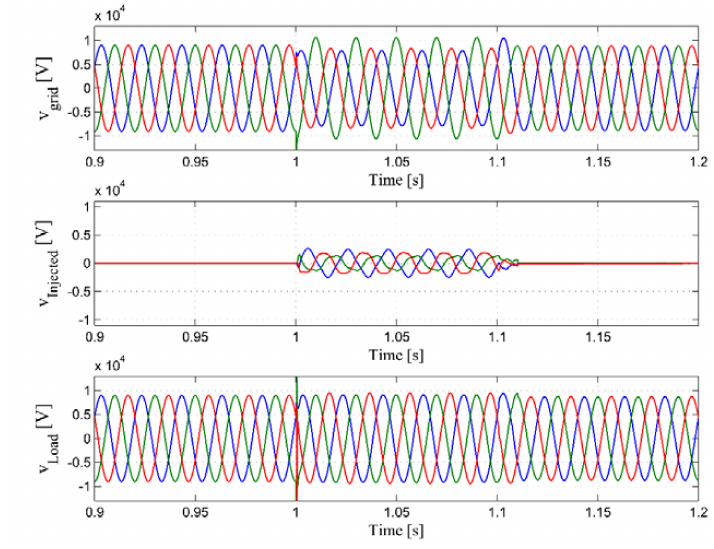
Figure 16. Case 5-Unbalanced voltage swell: grid voltage, injected voltage of the DVR and load